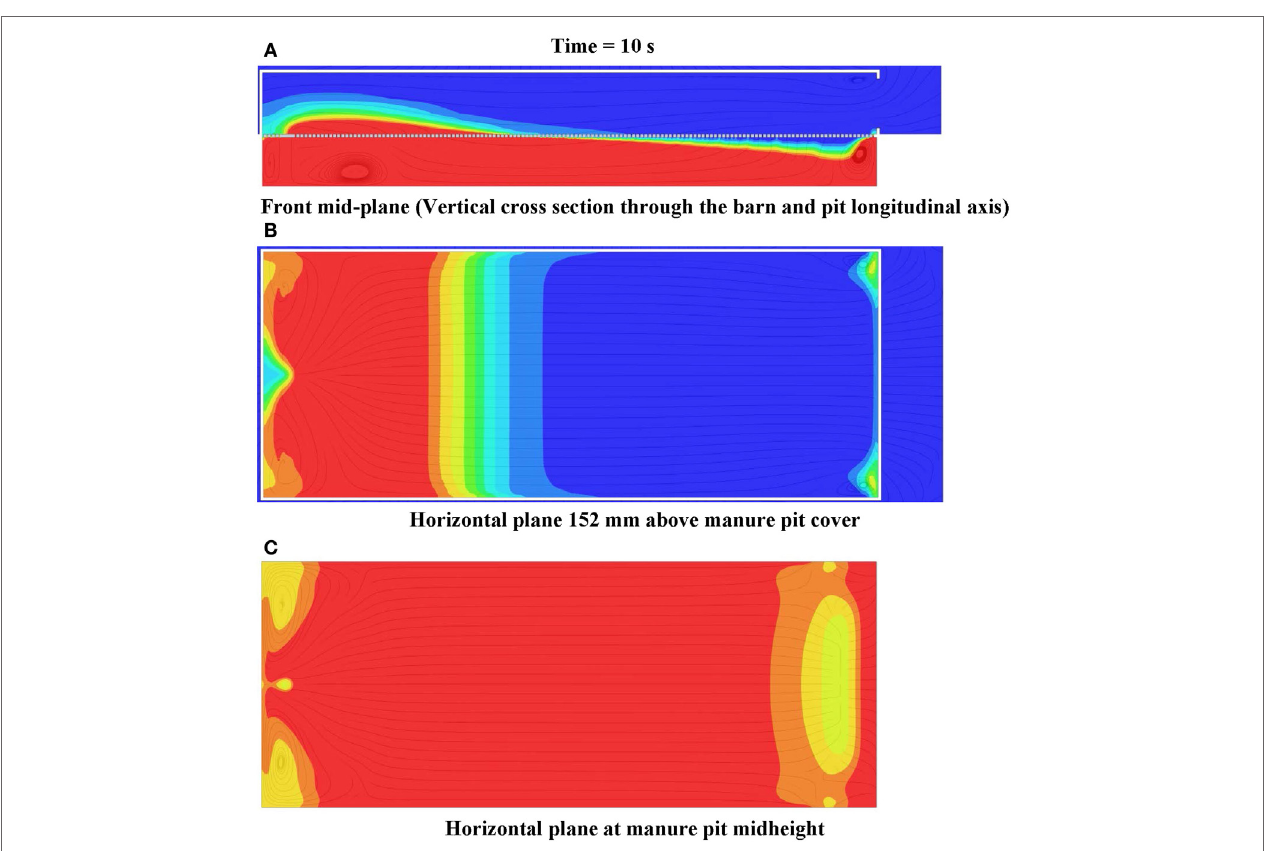
FIgURe 13 | Frames of (A) front mid-plane, (B) horizontal plane 152 mm above manure pit cover, and (c) horizontal plane at manure pit mid-height cut plot animations of hydrogen sulfide concentration 10 s after commencement of pit ventilation for case Study 1: tunnel ventilated (counter flow) barn above slotted-covered manure pit (see Figure 11 for color legend for hydrogen sulfide)